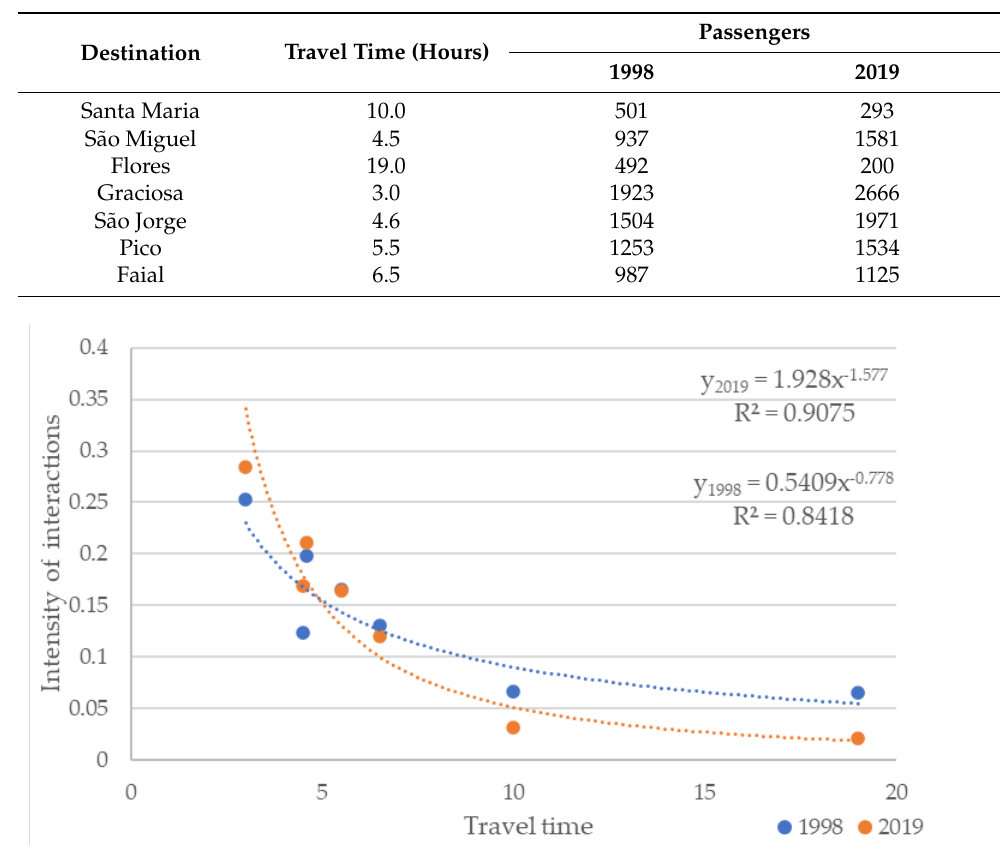
Figure 6. Intensity of interactions and travel time to Flores Island from the rest of the archipelago—for 1998 and 2019. Table 6. Data for maritime connections to Terceira Island from the rest of the archipelago—for 1998 and 2019.